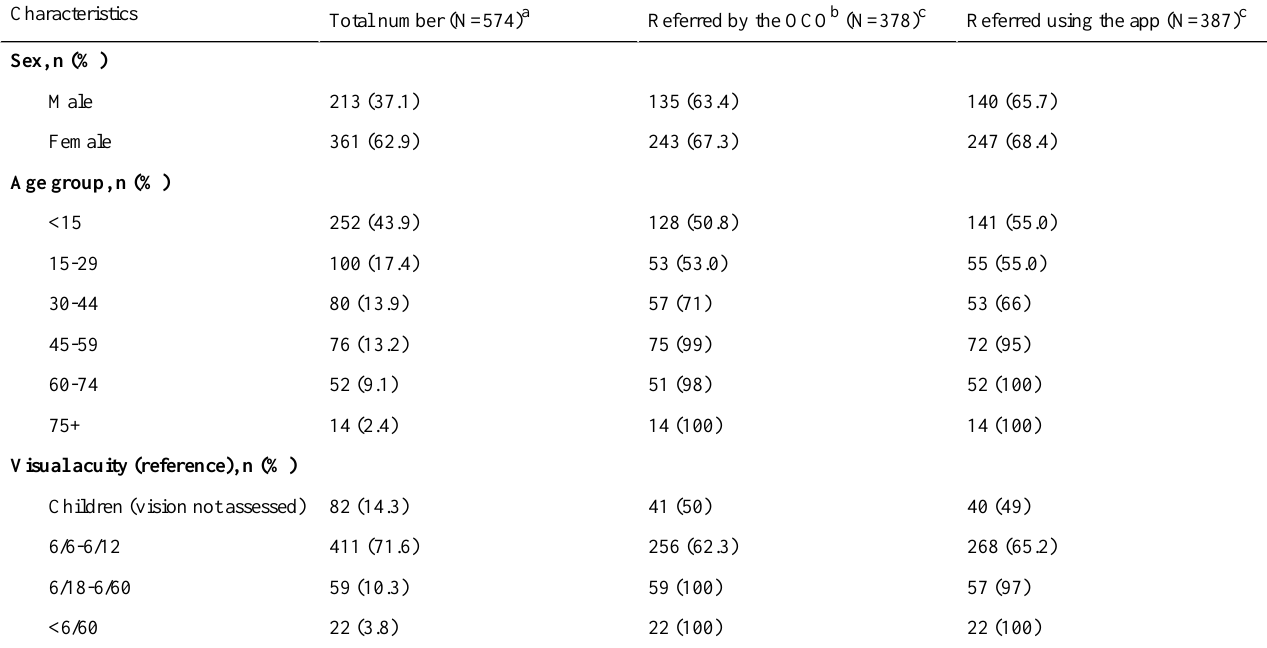
Table 2. Age, sex, and visual status of all study participants, those referred by the ophthalmic clinical officer using standard equipment and by community volunteers using the Peek Community Screening